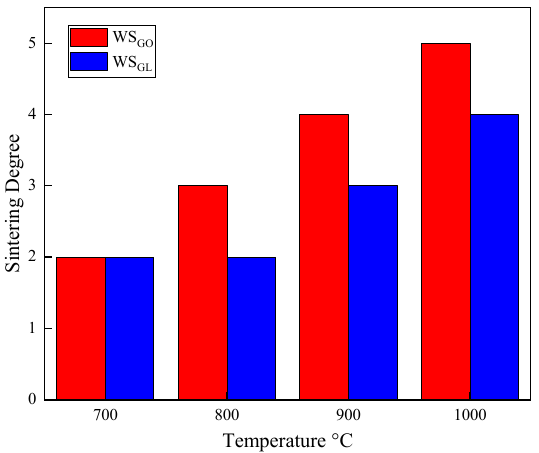
Figure 5. Sintering degrees of original and leached samples at different temperatures. (Degrees: 1: loose ash, 2: slightly sintered, 3: hard sintered, 4: very hard sintered, 5: completely melted).